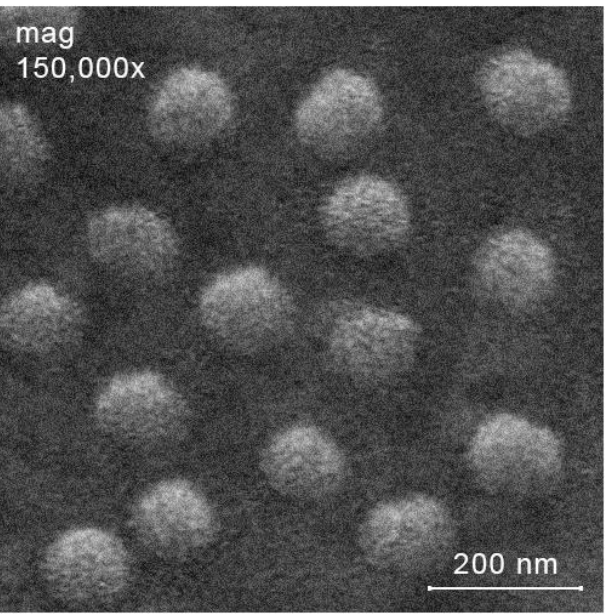
Figure 5. SEM image of loaded self-assembled nanoparticles. Table 7. Characteristics of loaded self-assembled nanoparticles (Scheme 1, system